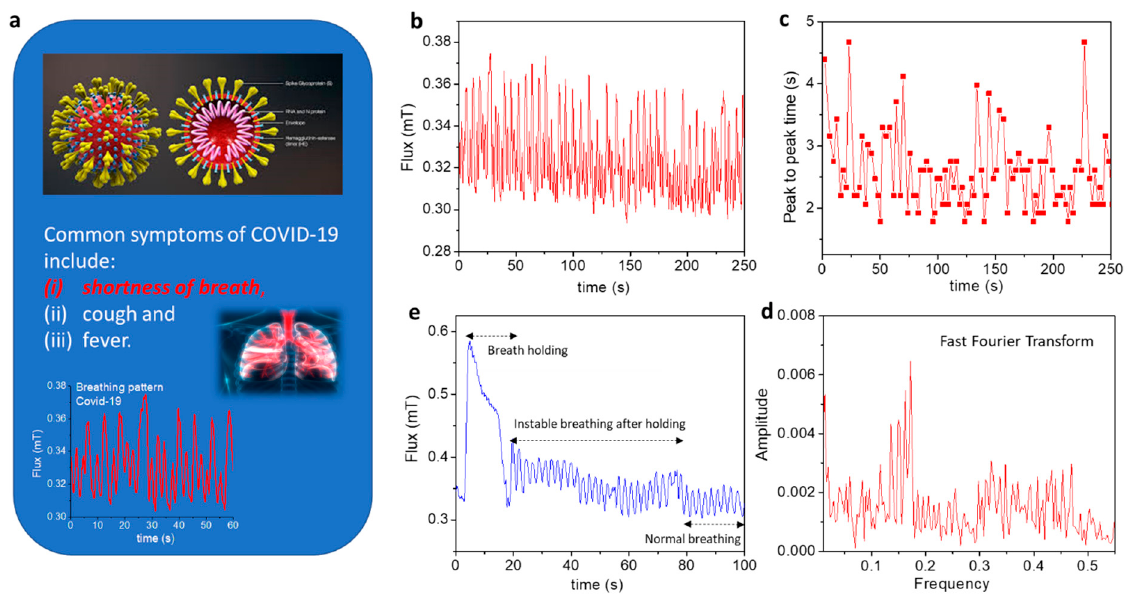
Figure 12. ( a ) Illustration of COVID-19 symptoms; top: schematic of the virus, bottom: breathing pattern of a patient with COVID-19. ( b ) Breathing pattern of the COVID-19 patient revealed irregular amplitude and several breathing anomalies. ( c ) Shortness of breath is evident from analysis of the peak-to-peak time versus measurement time. ( d ) The broad distribution of frequencies deduced from Fourier transform also reveals these features. ( e ) The COVID-19 patient lost the ability to hold his/her breath for a long time and required a much longer time to return to normal breathing.